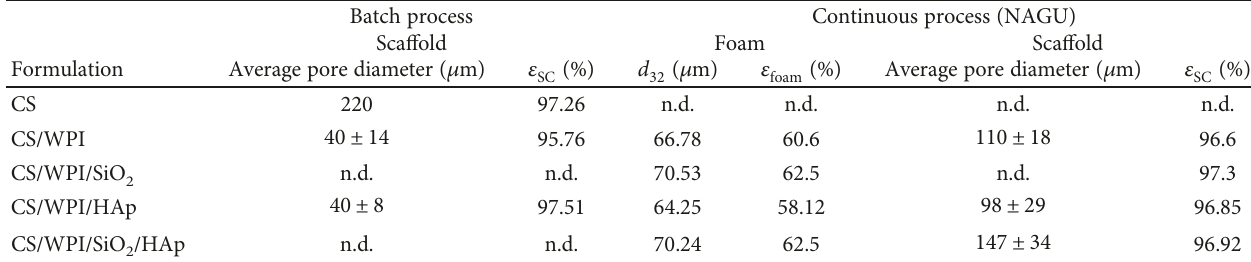
Table 6: Pore size and gas volume of fresh foams and sca ff olds (dried foam) obtained in batch and continuous procedures ( L = 30 mL min − 1 , G = 50 mL min − 1 , and N = 600 rpm